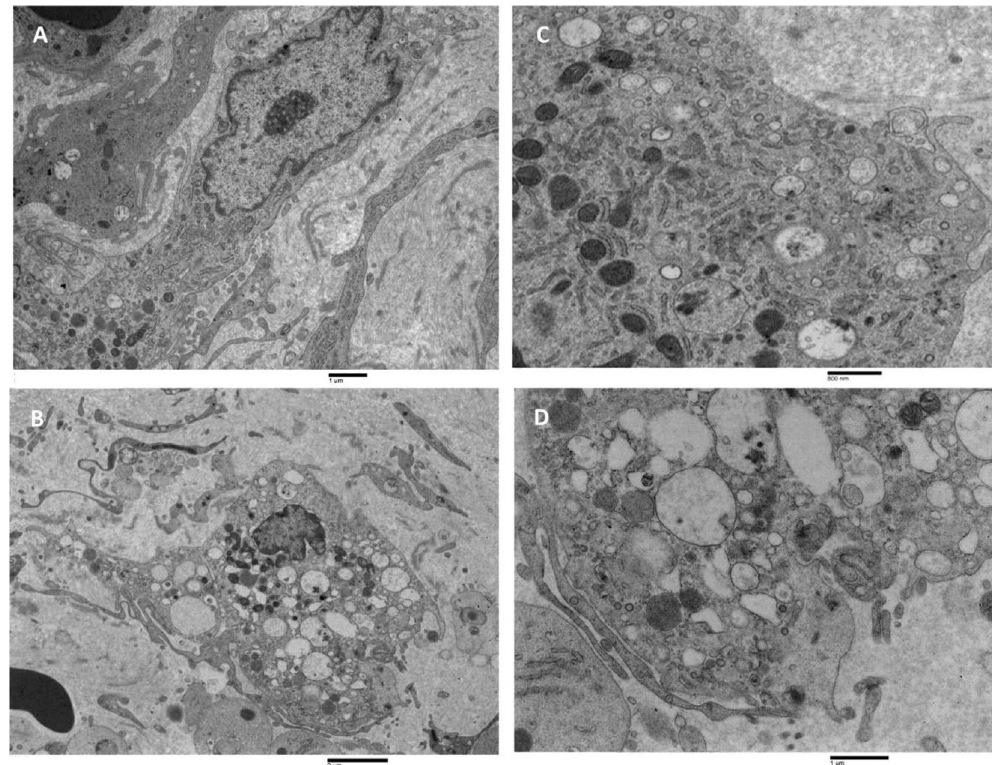
Figure 10. TEM analysis of the CSDH inner membrane. ( A , B ) Large cells with irregular nuclei with marginated chromatin and prominent nucleolus (in A ); their cytoplasm is very rich in cellular organelles such as rough endoplasmic reticulum, Golgi apparatus, mitochondria; dilated rough endoplasmic reticulum (in B ). ( A ) 14,000 ×, bar = 1 µm; ( B ) 10,900 ×, bar = 2 µm. ( C , D ) Closer view of large cells cytoplasm showing the ultrastructure of dilated rough endoplasmic reticulum (typically structured in C ), swollen mitochondria, numerous microvesicles, and multivesicular bodies. ( C ) 24,800 ×, bar = 800 nm; D: 21,300 ×, bar = 1